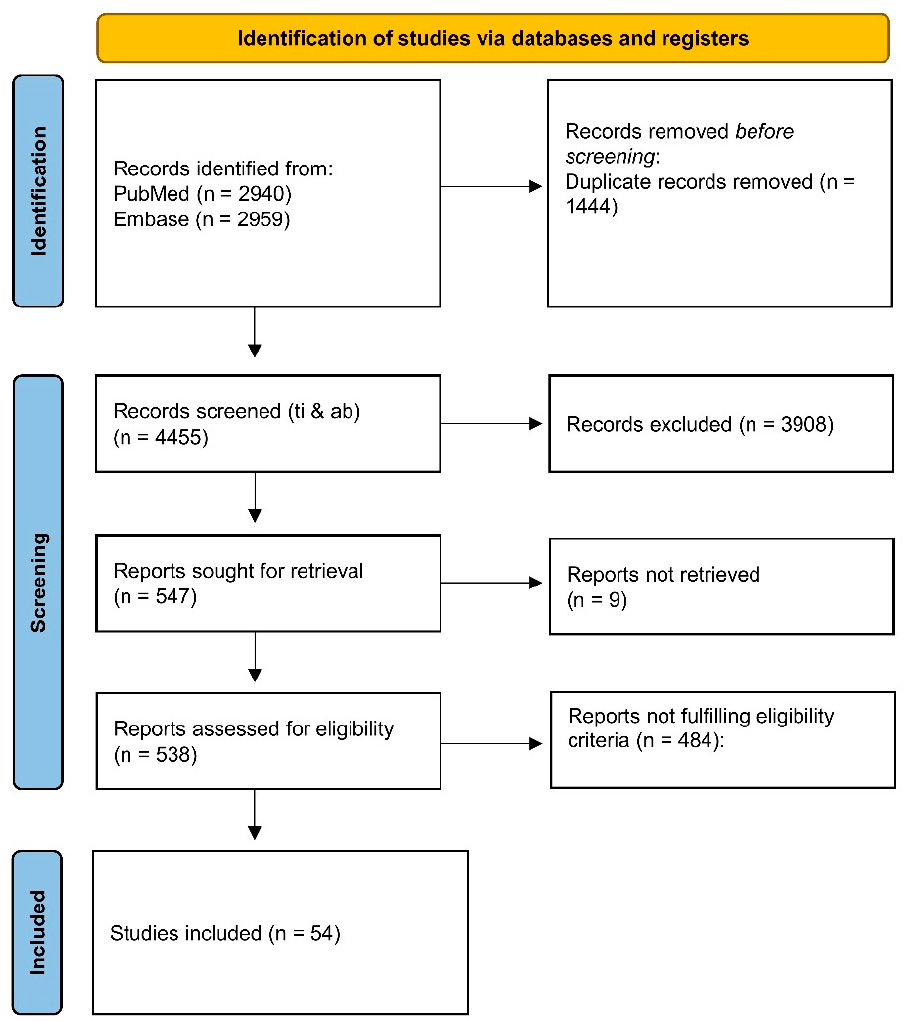
Figure 1. Preferred Reporting Items for Systematic Reviews and Meta-Analyses (PRISMA) flow chart. The diagram outlines the databases queried, the number of titles/abstracts screened, the full-text documents retrieved, and the number of included and excluded studies. Ti & ab, title and abstract